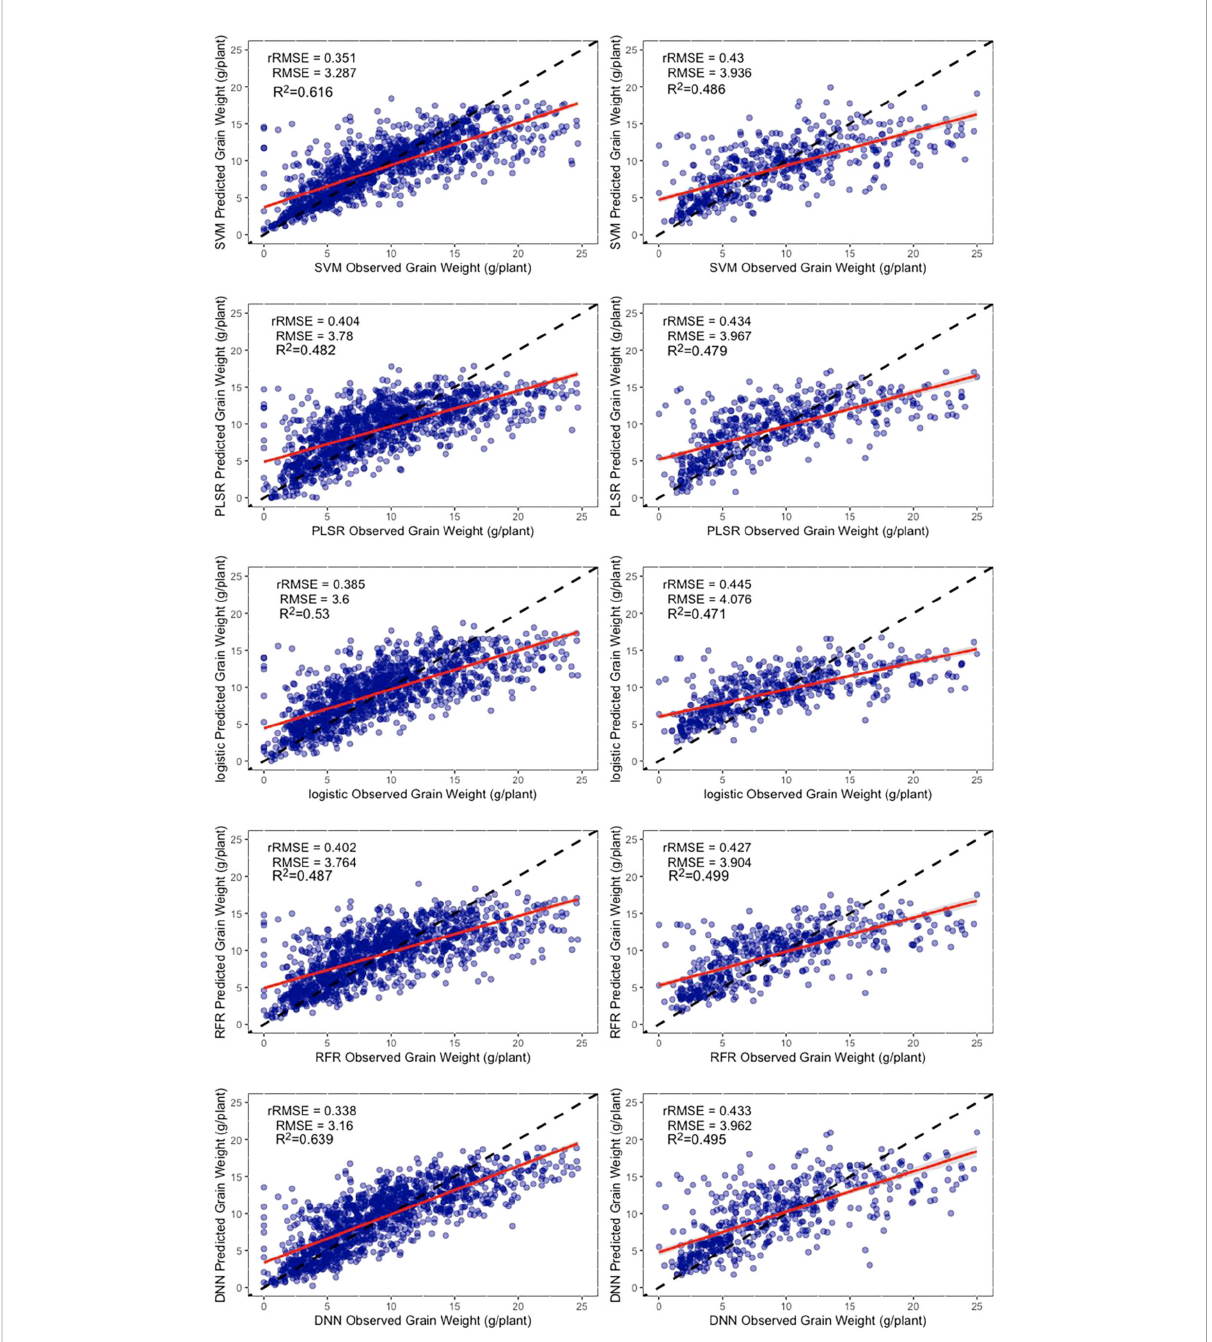
FIGURE 9 Results of the machine learning algorithms to estimate the grain weight per plant. The left column is the training dataset, and the right column is the validation dataset. The black dashed line is the 1:1 line, and the solid red line is the data fi tted line. SVM, support vector machines regression; RFR, random forest regression; PLSR, partial least squares regression; Logistic, logistic regression; DNN, deep neural